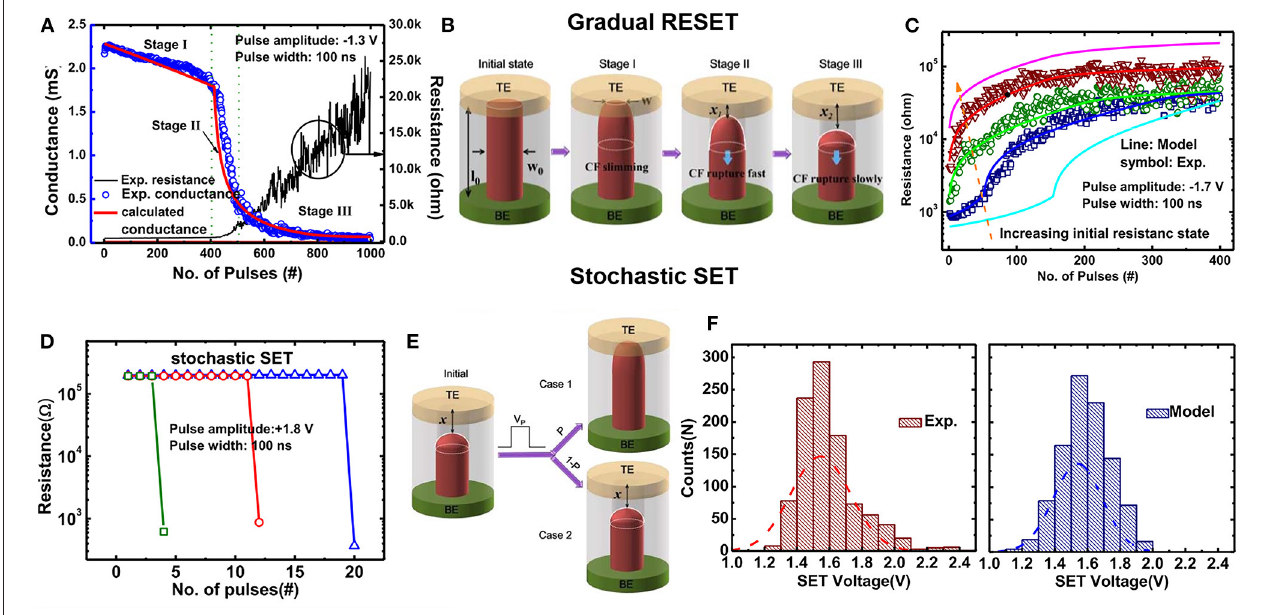
FIGURE 4 | (A) Measured gradual RESET under consecutive identical pulses. (B) CF evolution model of gradual RESET. (C) Measured and calculated gradual RESET with different initial states. (D) Measured binary stochastic SET under consecutive identical pulses. (E) Model for stochastic SET. (F) Measured and calculated SET voltage distributions in 1,000 cycles. Reprinted from Huang et al.